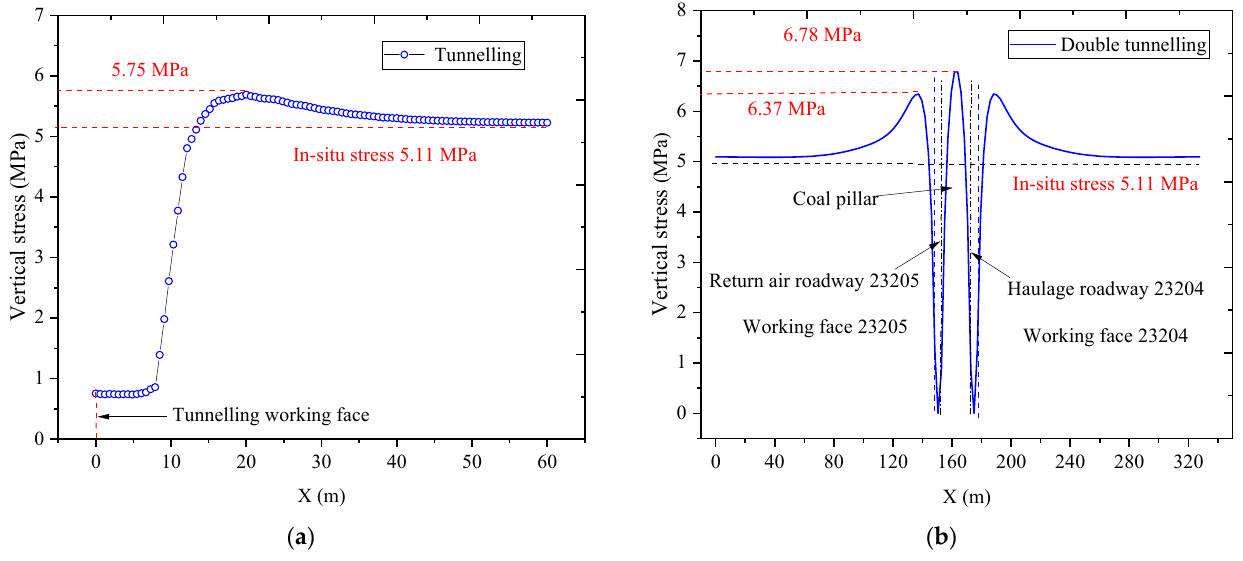
Figure 9. The stress evolution law of the surrounding rock during the tunneling: ( a ) stress distribution in the front of the tunneling; ( b ) stress distribution in the middle of the roadway after the tunneling.